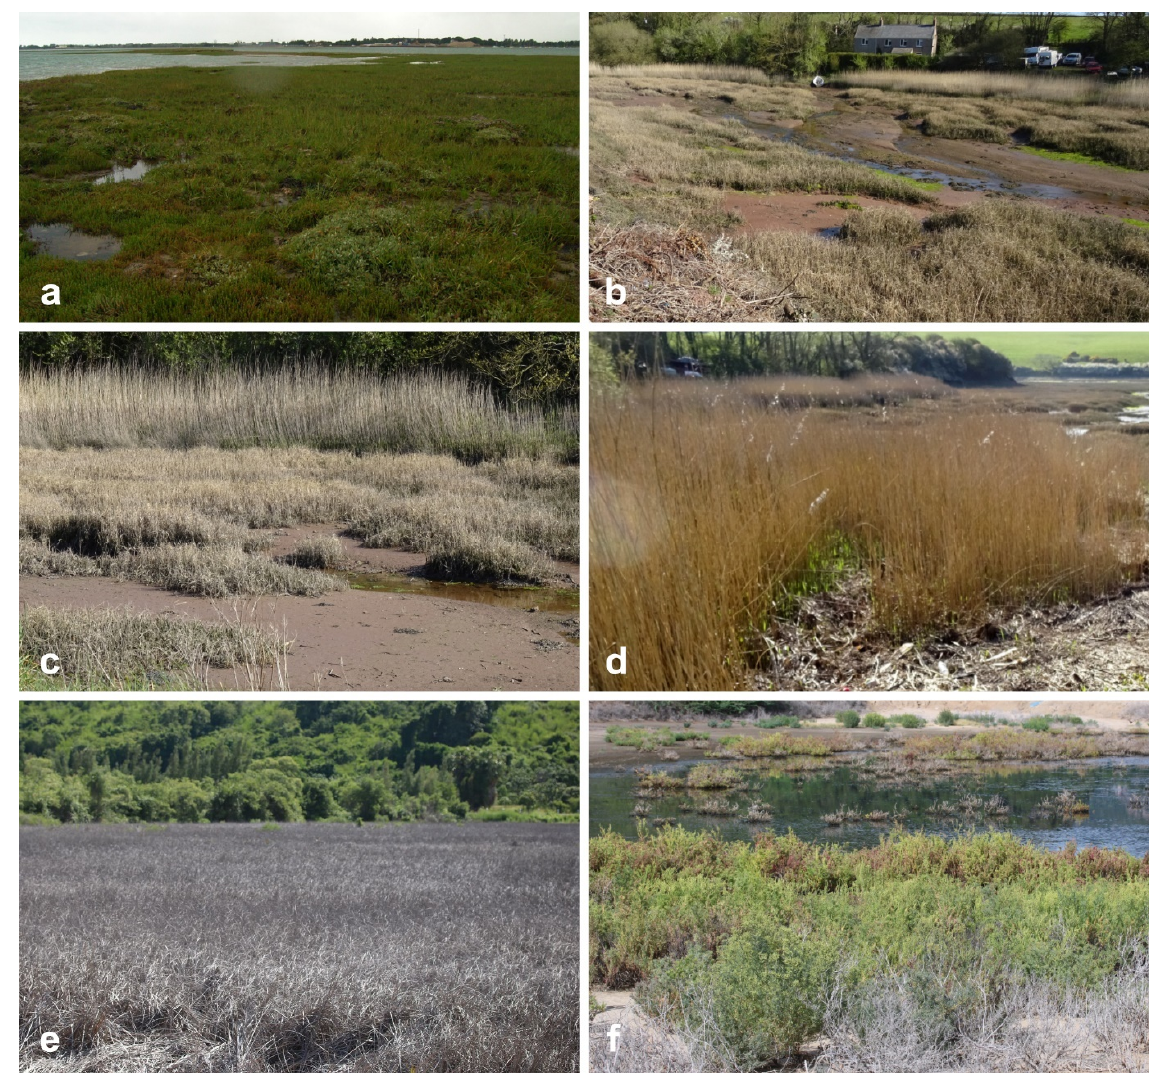
Figure 1. Salt marsh ecosystems in UK ( a – d ) and Thailand ( e – f ). ( b – d ) Tidal grasses, Spartina townsendii (Poaceae) and Phragmites (Poaceae), dominate the salt marsh in UK (50°49′55.4″ N 0°58′25.1″ W; 51°43′03.1″ N 5°10′24.8″ W); ( e ) Spartina (Poaceae) (12°22′4.0″ N 99°59′6.7″ E) ( f ) and Suaeda (Amaranthaceae) (12°10′19.6″ N 99°58′20.3” E) in tidal marsh areas in southern Thailand.